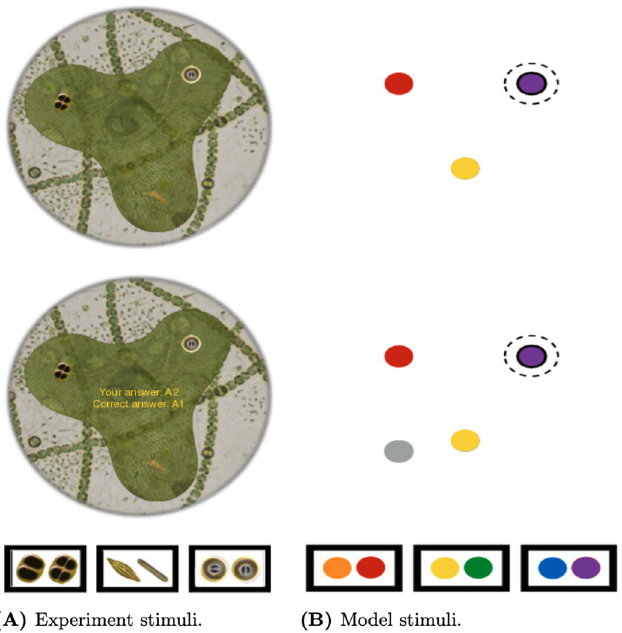
Fig 5. Simulation 1 model fits. Each measure is depicted over 360 trials averaged into 24 bins of 15 trials. Color shading represents standard error of the mean accumulated from individuals and population. A) Trial accuracy means and variability are fit well. B) Fixation duration variability is fit well but the final late reduction means are diverge. C) Fixation count means, variability and change are qualitatively fit well. D) Probability of fixating the irrelevant shows roughly the same change and variability over the experiment, however the scale is off by about 25% at all points. E) Reaction time means, variability and change are qualitatively fit well. F) Total time looking at features during feedback has roughly the right change and variability but the scale is off by 50% at all